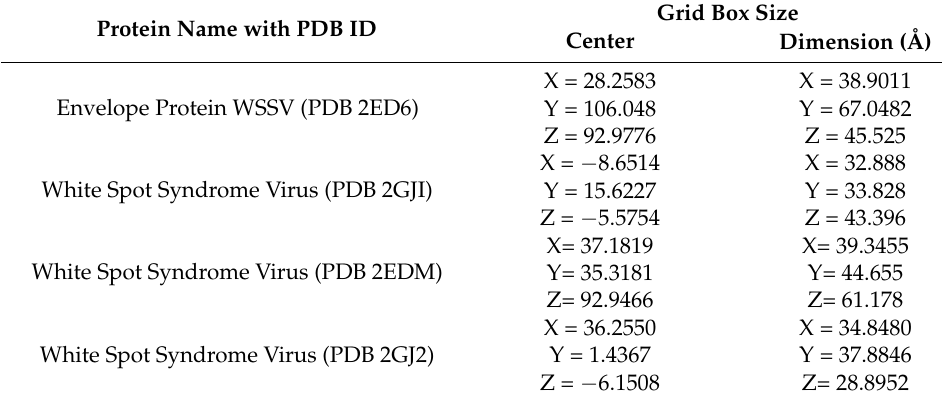
Grid Box Size Center Dimension (Å) X = 28.2583 X = 38.9011 Z = 92.9776 X = − 8.6514 X = 32.888 Y = 15.6227 Y = 33.828 Z = 43.396 X=